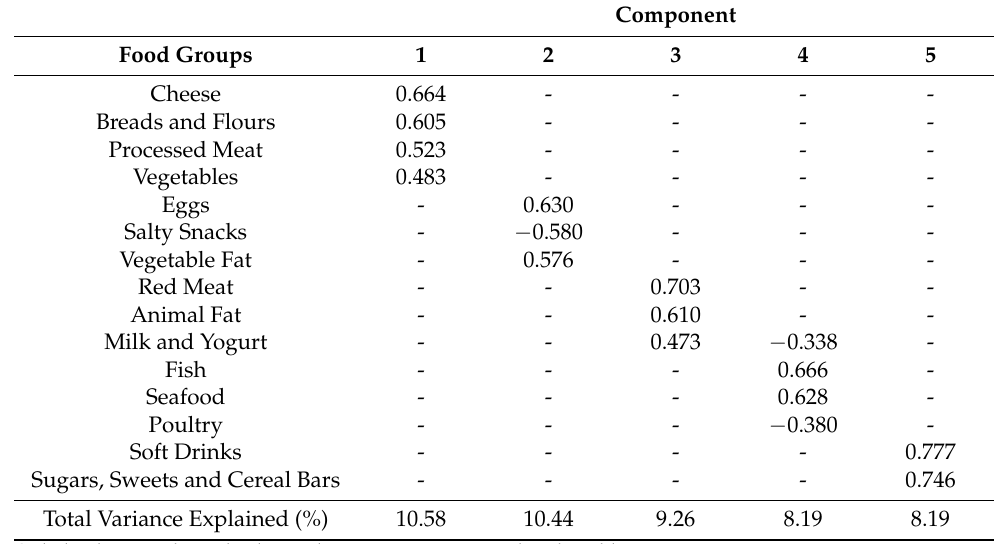
Table 4. Principal Components Analysis’ factor loadings for the 15 food groups in the STANISLAS Family study. ( n =